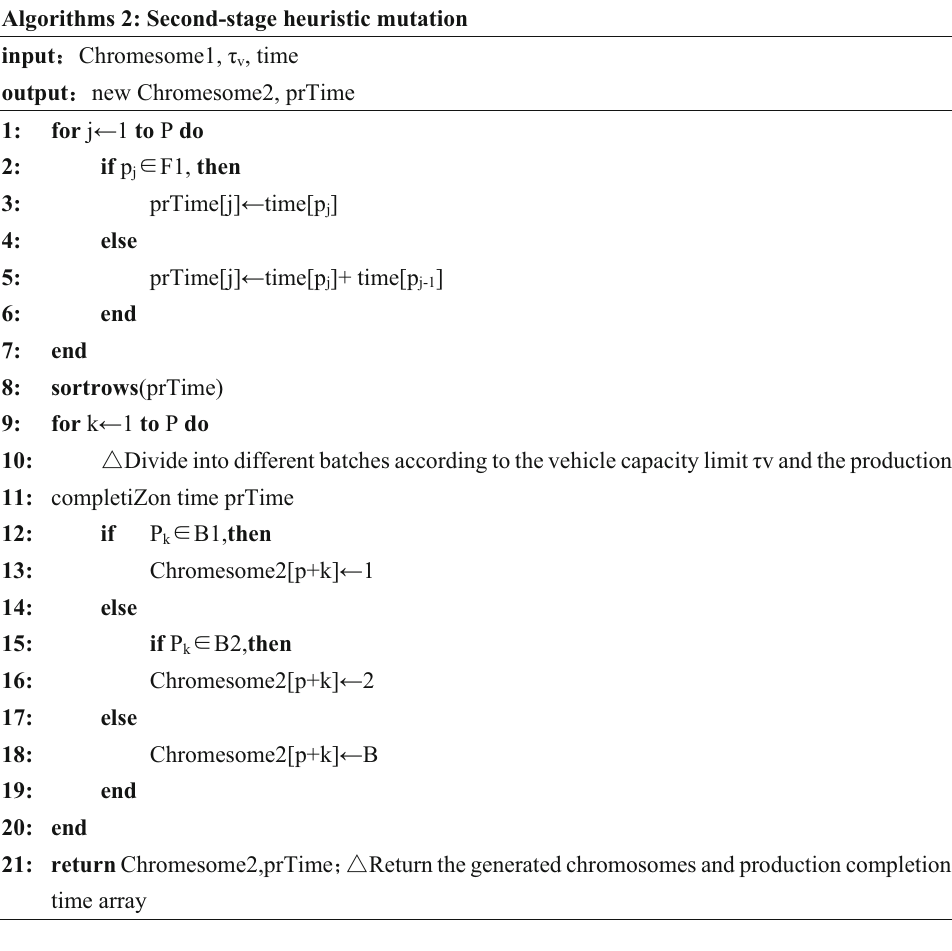
Tabu search algorithm for local